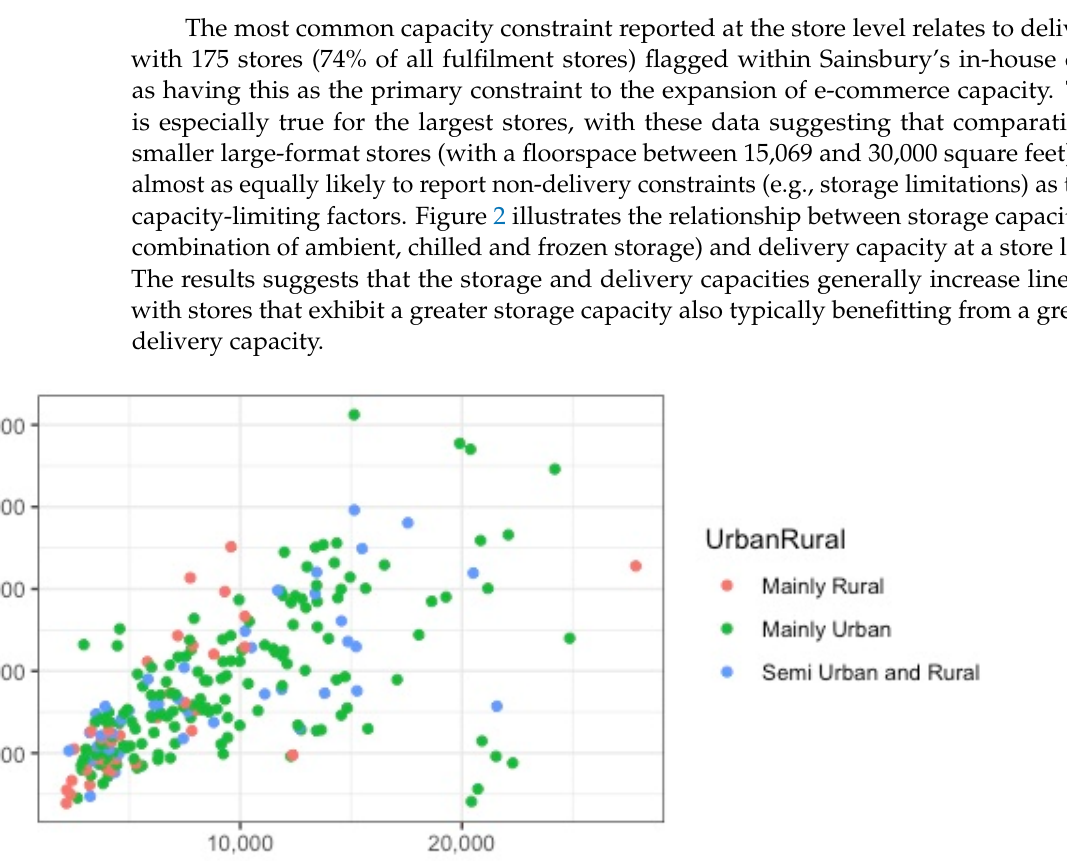
Table 4. Correlations between storage and delivery capacities by store characteristic.